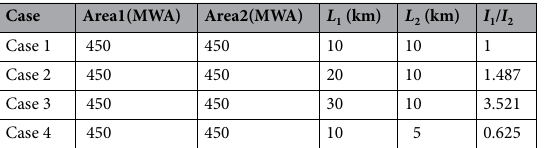
Table 1. Relation between electrical distance and inertia